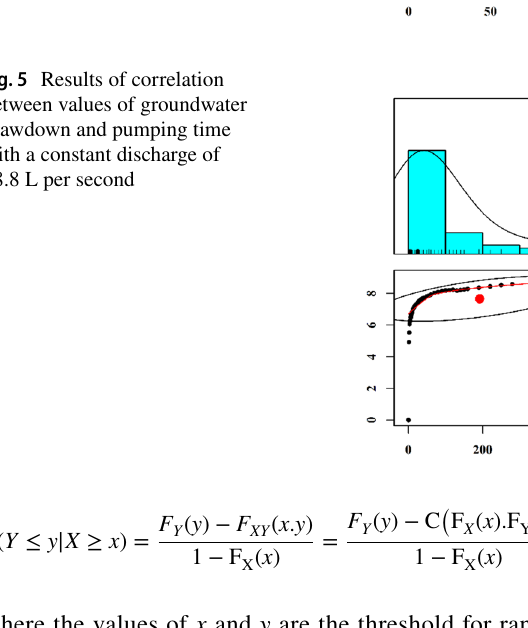
Fig. 5 Results of correlation between values of groundwater drawdown and pumping time with a constant discharge of 28.8 L per second